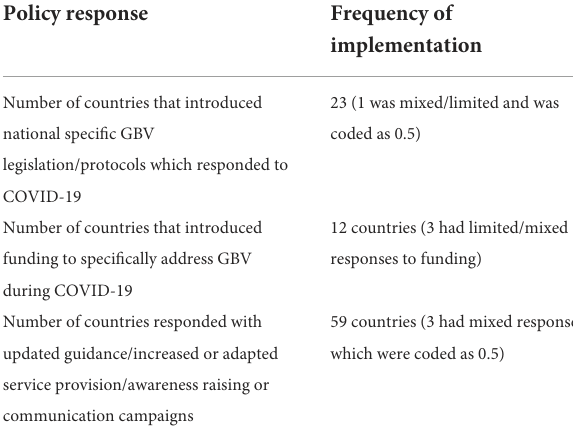
TABLE 2 Government policy responses to GBV during